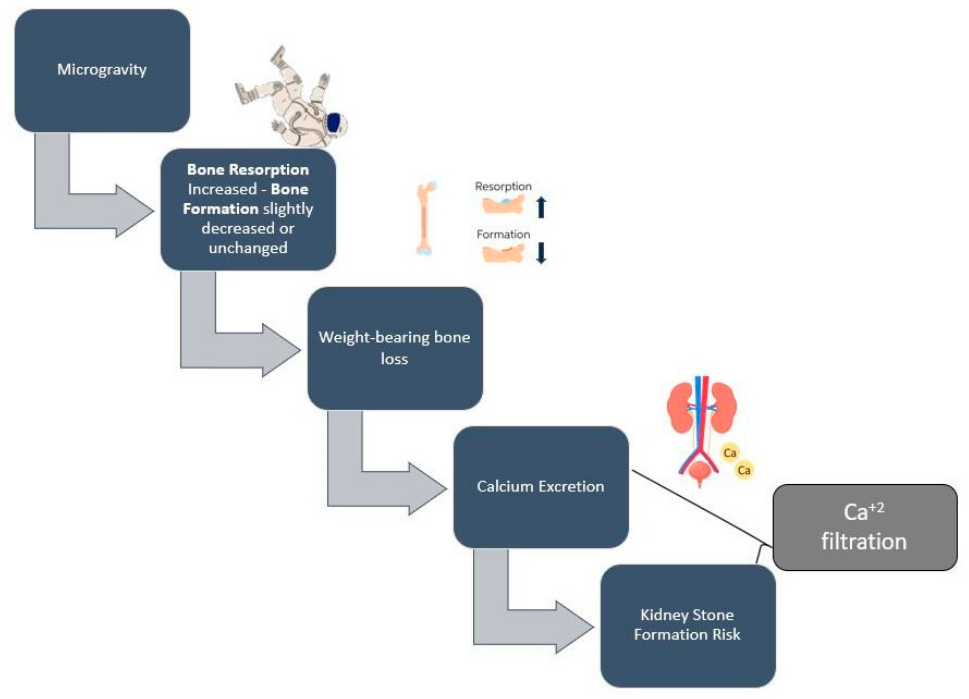
Figure 2. Simplified proposed mechanism of spaceflight-induced bone loss and kidney stone formation risk. tion